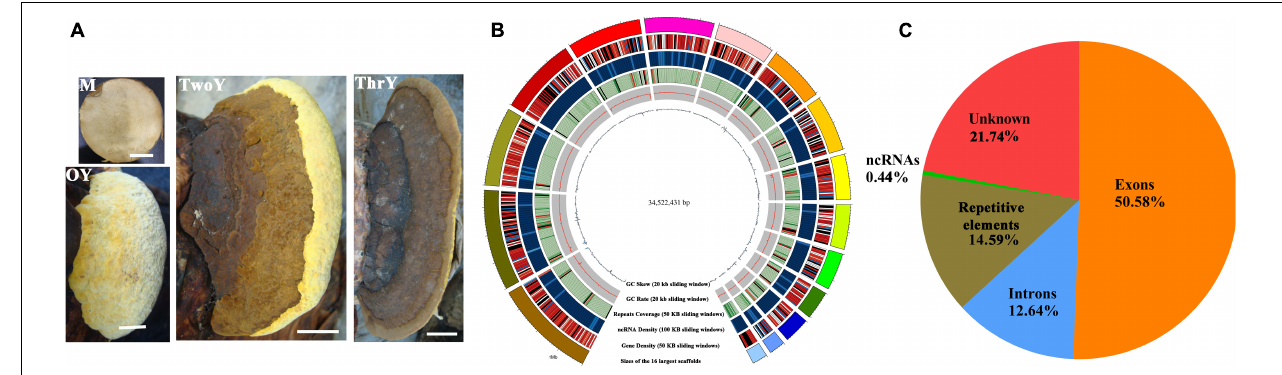
FIGURE 2 | Growth characteristics and general genomic features of S. sanghuang Kangneng . (A) The four developmental stages in the life cycle of the fungus. M, aerial mycelia; OY, one-year-old fruiting bodies; TwoY, two-year-old fruiting bodies; ThrY, three-year-old fruiting bodies. Bar = 3 cm. (B) Characteristics of the de novo assembly genomic features. From the outside to the inside are: I, scaffolds, the different colors represent different scaffolds (scaffolds length > 1 Mbp were chosen); II, gene density; III, the density of non-coding RNA; IV, percentage of coverage of repetitive sequences; V, GC content estimated by the percentage of G + C in 20 kb; VI, GC skew was estimated with (G–C)/(G + C) in 20 kb. (C) Genomic element density.